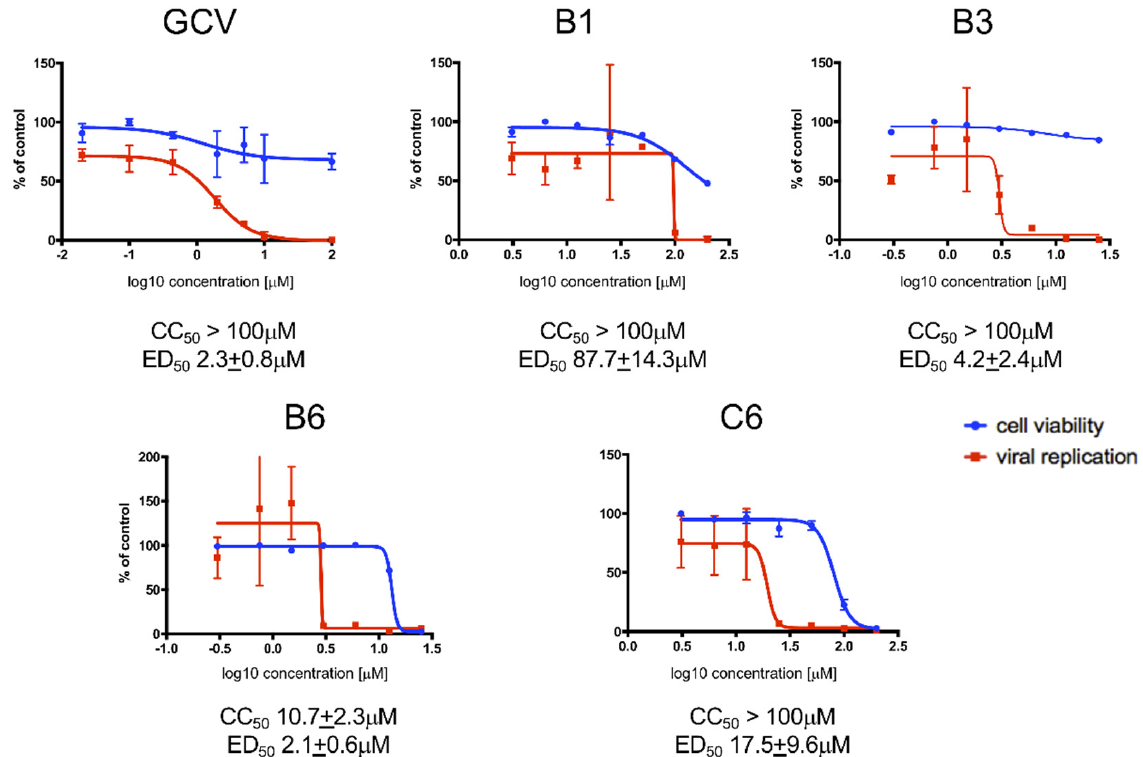
Figure 3. Determination of ED 50 and CC 50 values of SMs by FRA and MTT assay. MRC5 cells were infected with TB4-UL83-EYFP at an MOI of 0.03 IU/cell and treated with increasing concentrations of the indicated compounds. In parallel, uninfected MRC5 cells were also treated for assessment of SMs cytotoxicity. Seven days post treatment, cells were processed for data acquisition and analysis as described in the Materials and Methods section. Mean values YFP values relative to infected cells treated with the indicated compounds are expressed as a percentage of DMSO-treated cells (red squares). Cell viability was assessed by MTT assays, and data expressed as a percentage of DMSO treated cells (blue circles). For each compound, representative plots are shown, along with the cytotoxic concentration 50 (CC 50 ) and effective dose 50 (ED 50 ) mean values + standard deviation of the mean relative to at least 4 independent